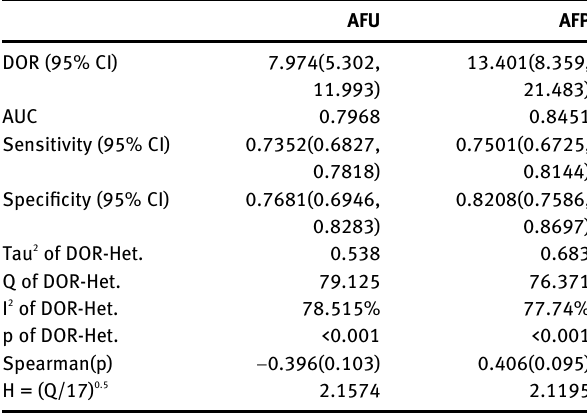
Table  : DOR, sensitivity, and speci fi city of AFU and